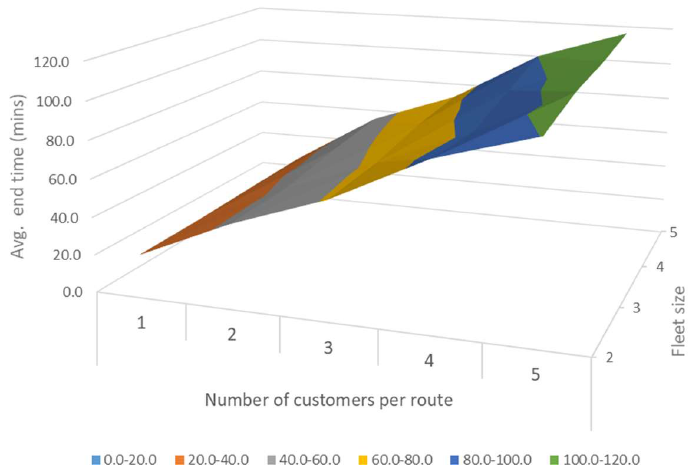
Figure 13. Average total distance travelled in km when the number of customers per route and fleet size is changing for sub-missions.